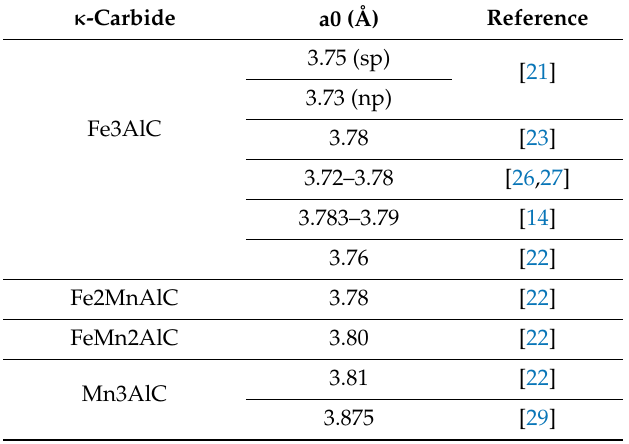
Table 1. The lattice parameters of κ -carbide given by relevant references.